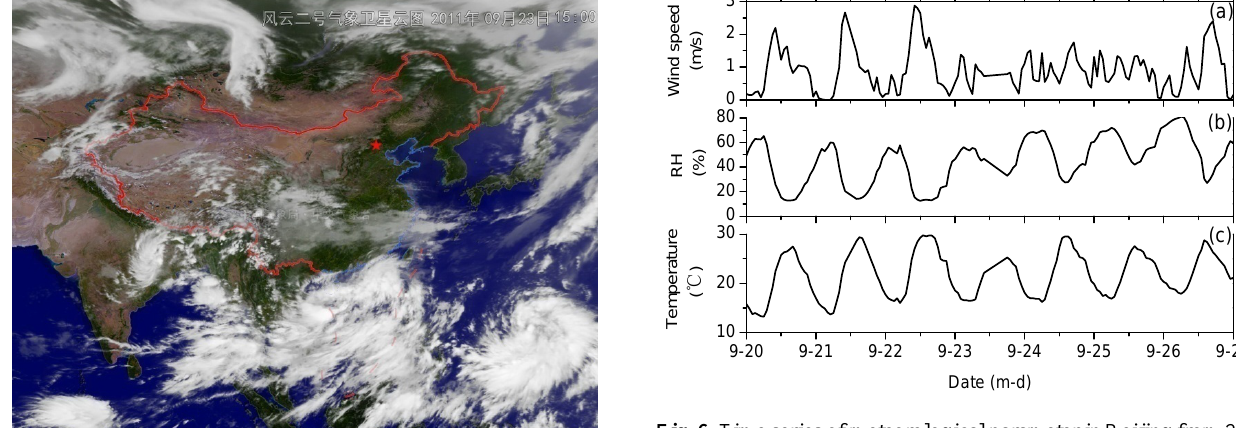
Fig. 6. Time series of meteorological parameter in Beijing from 20– 27 September 2011. (69.7 ± 25.3 µg m − 3 ) on 23 September. Furthermore, the